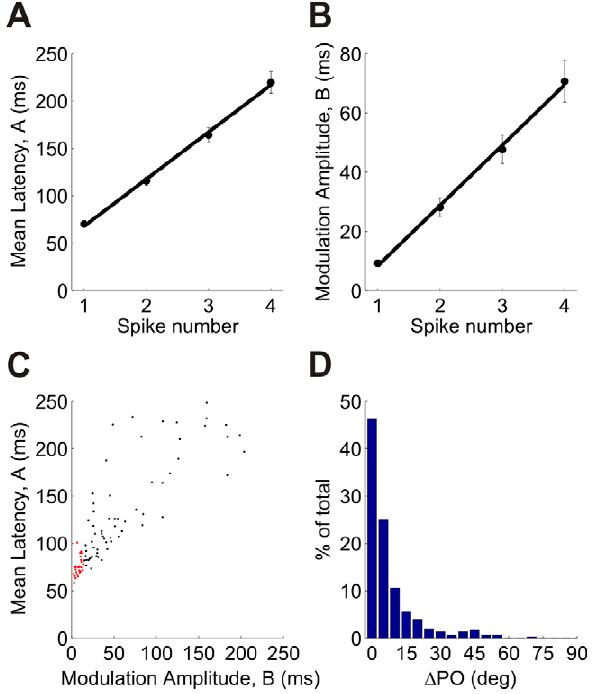
Figure 3. Population statistics of latency tuning. The tuning curves were fitted using a cosine function, L h ; Q ð Þ ~ A { B cos 2 h { Q ð Þð Þ , where h is the stimulus orientation and Q is the latency preferred orientation. (A) Dependence of the mean DC component, A , on spike number (averaged over the population). (B) Dependence of the modulation amplitude, B , on spike number (averaged over the population). Error bars in (A) and (B) represent 6 onestandard error of the mean. (C) A scatter plot of A vs. B for first spike latency (each point represents one unit; correlation coefficient 0.85). The cells that are marked in red are onset detectors (see text and Figure 4). The statistical analyses in panels (A)–(C) were performed using dataset 3 in Table 1 (159 cells). Similar results were obtained for the other 4 datasets. The correlation coefficients between A and B were, in decreasing order: 0.88, 0.84, 0.76 and 0.66 (D) Histogram of the difference between the first spike latency-based preferred orientation and the conventional rate- based preferred orientation. In order to avoid artifacts from poorly tuned cells, the histogram shows only cells for which the modulation, B , of the first spike latency tuning curve was larger than 15 ms ( , 50% of the cells from datasets 1 to 5 in Table 1).